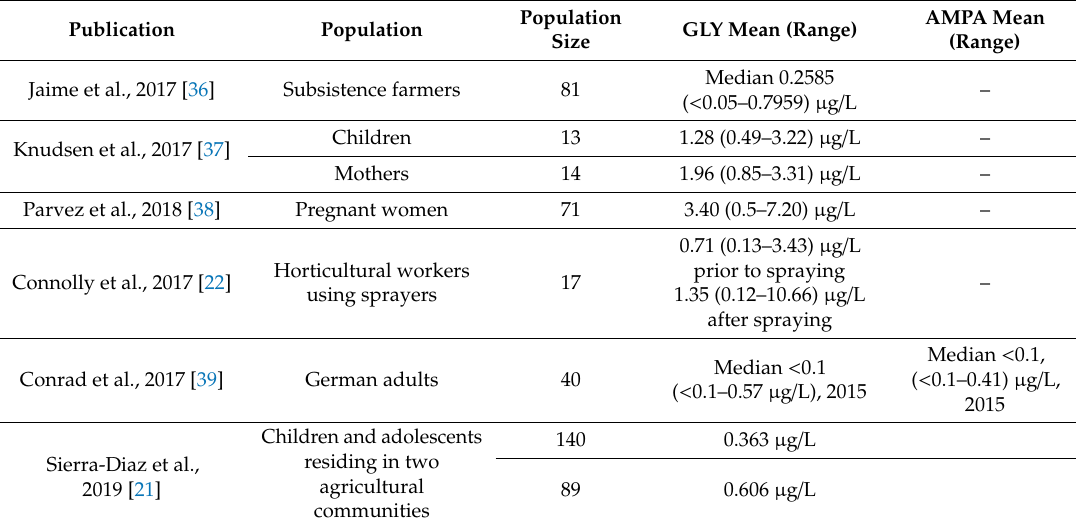
Table 4. The urinary GLY and AMPA concentration in some recent research